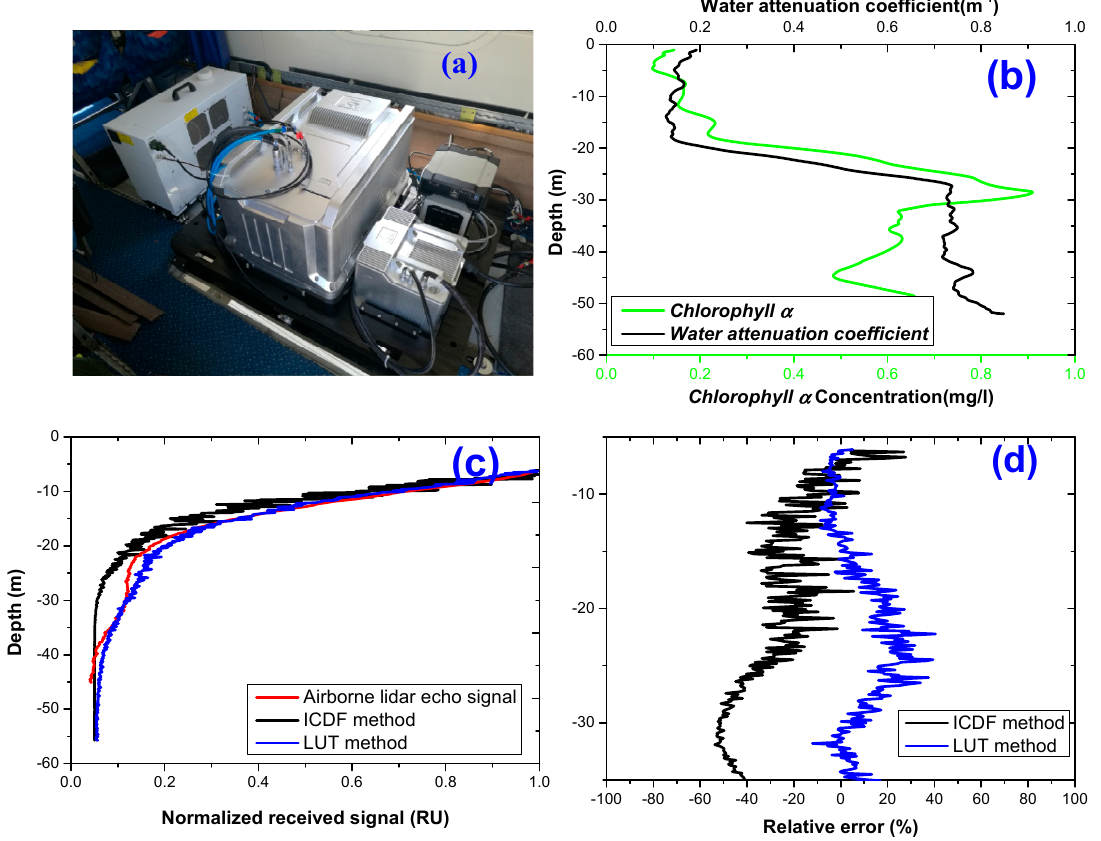
Figure 6. Simulated-signal vs. airborne lidar measured-signal: ( a ) Airborne lidar photo, ( b ) chlorophyll and c ( z ) profiles, ( c ) simulated signal vs. lidar measured-signal, and ( d ) error curve of comparison.